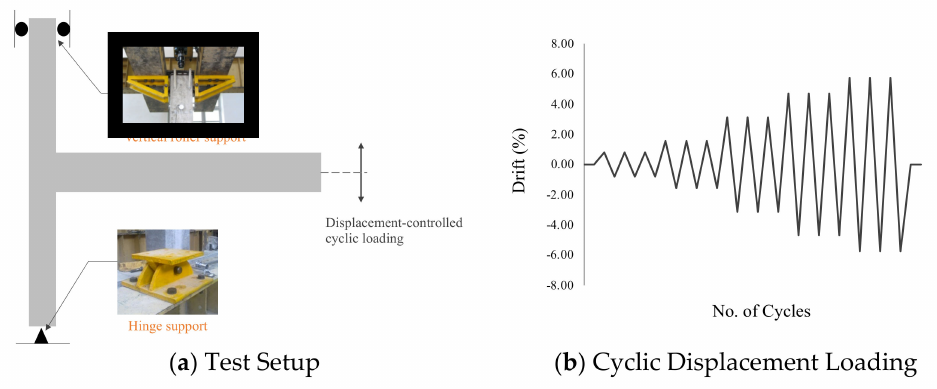
Figure 14. Schematic representation of test specimen setup and